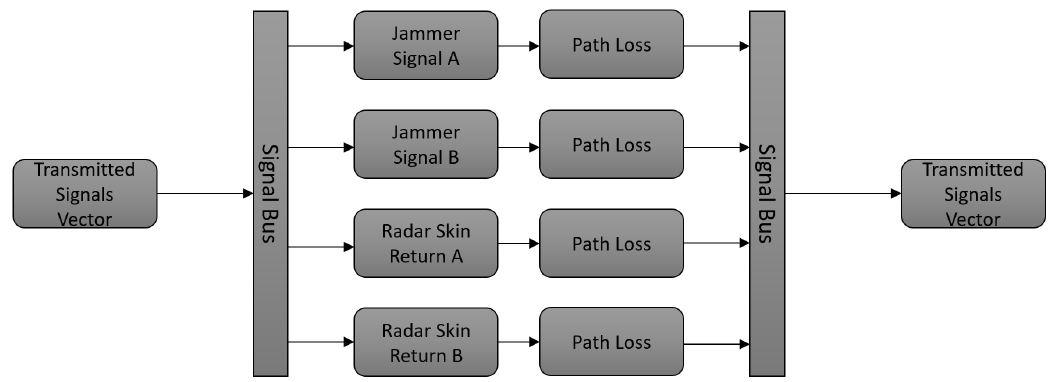
Figure 13. The received signal power subsystem takes the received signal vectors, and using the transmitted power and RF path-parameters, calculates the path loss and received power in each case.